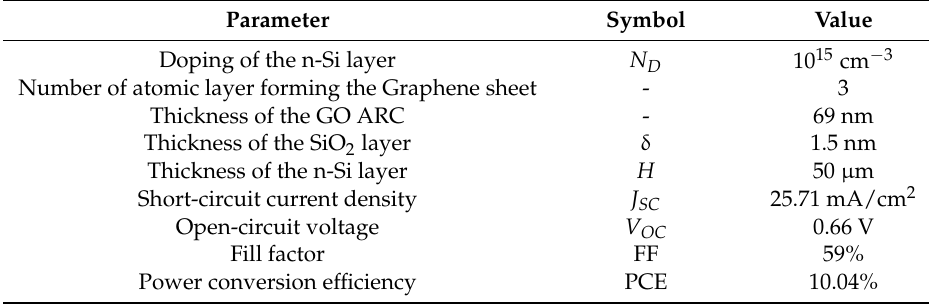
Table 5. Features and performance of the optimized solar